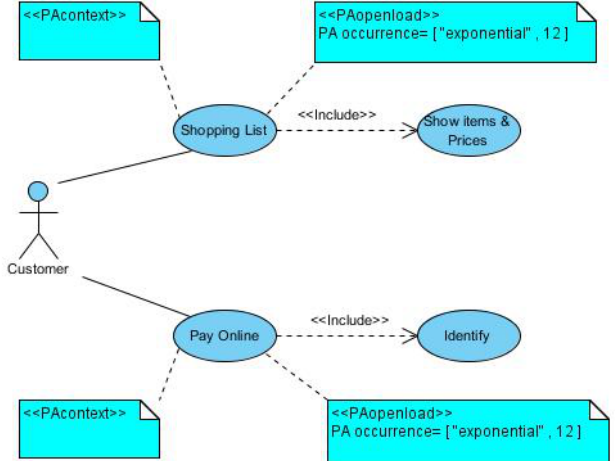
Fig. 3. The margined use case diagram pertaining to the online